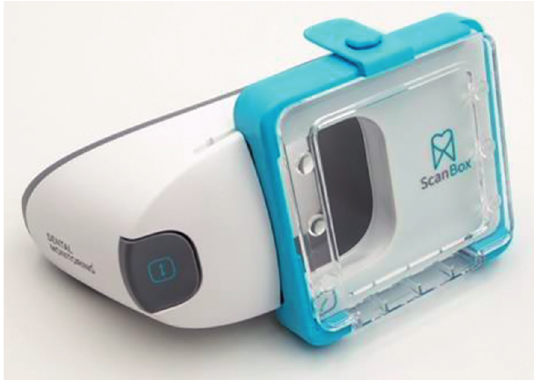
Figure 3: Closed view of the ScanBox